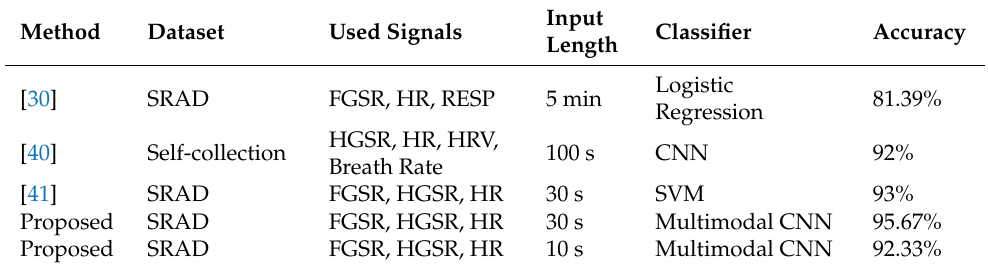
Table 7. Comparison of other 2-class stress classification methods in real-time driving